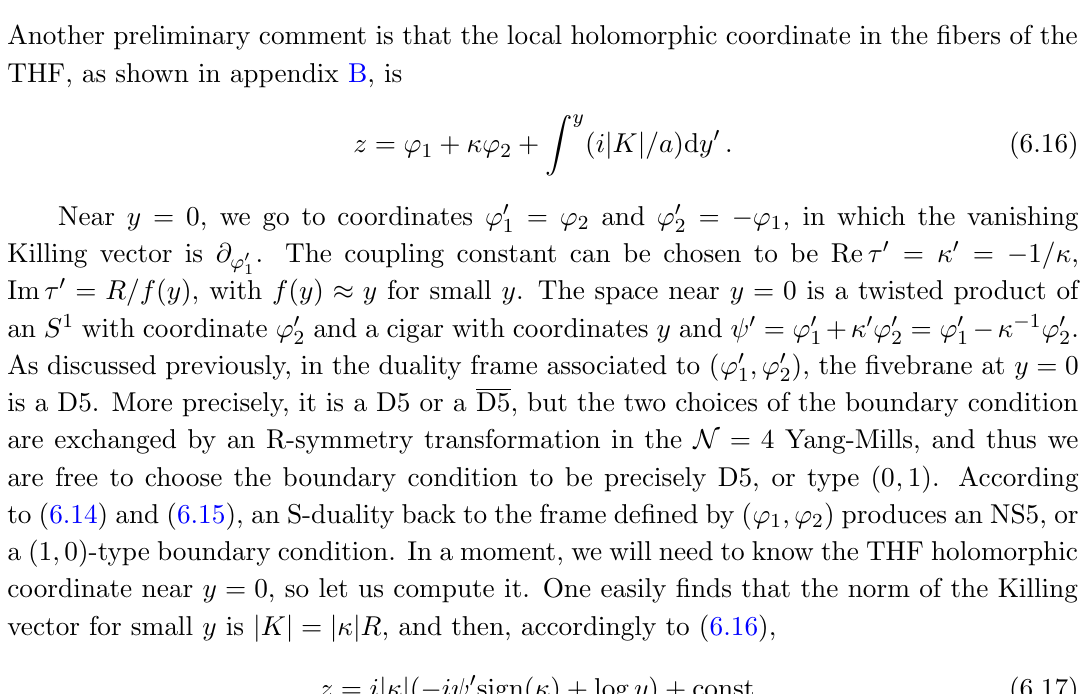
Figure 9 . These brane con(cid:12)gurations are obtained from reducing on a lens space L k for real a THF parameter (cid:20)